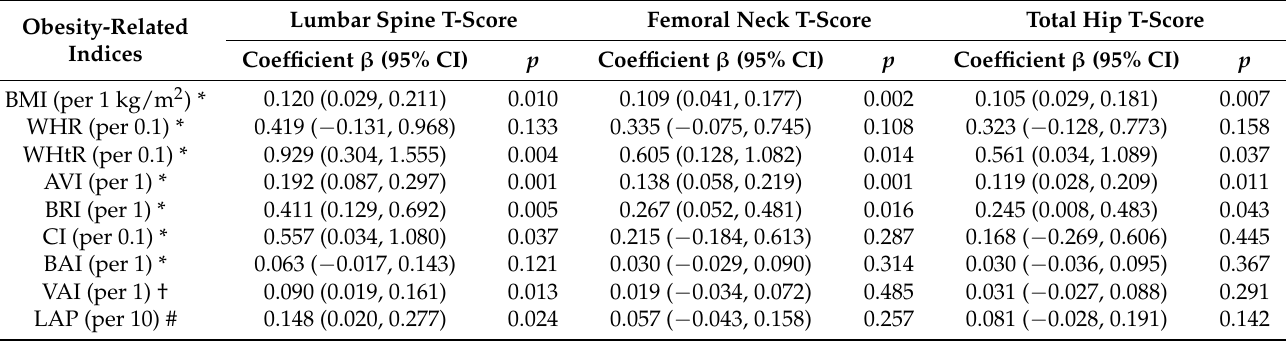
Table 3. Association between obesity-related indices and BMD T-score using multivariable linear regression analysis in patients with MetS ( n =